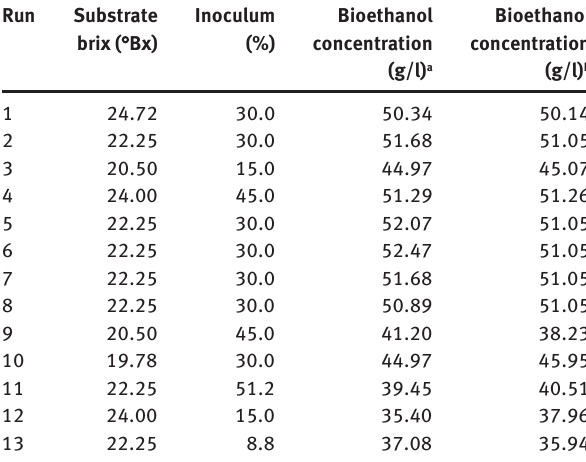
Table 3: Matrix of the CCD for bioethanol production using the NCYC 4109 yeast.